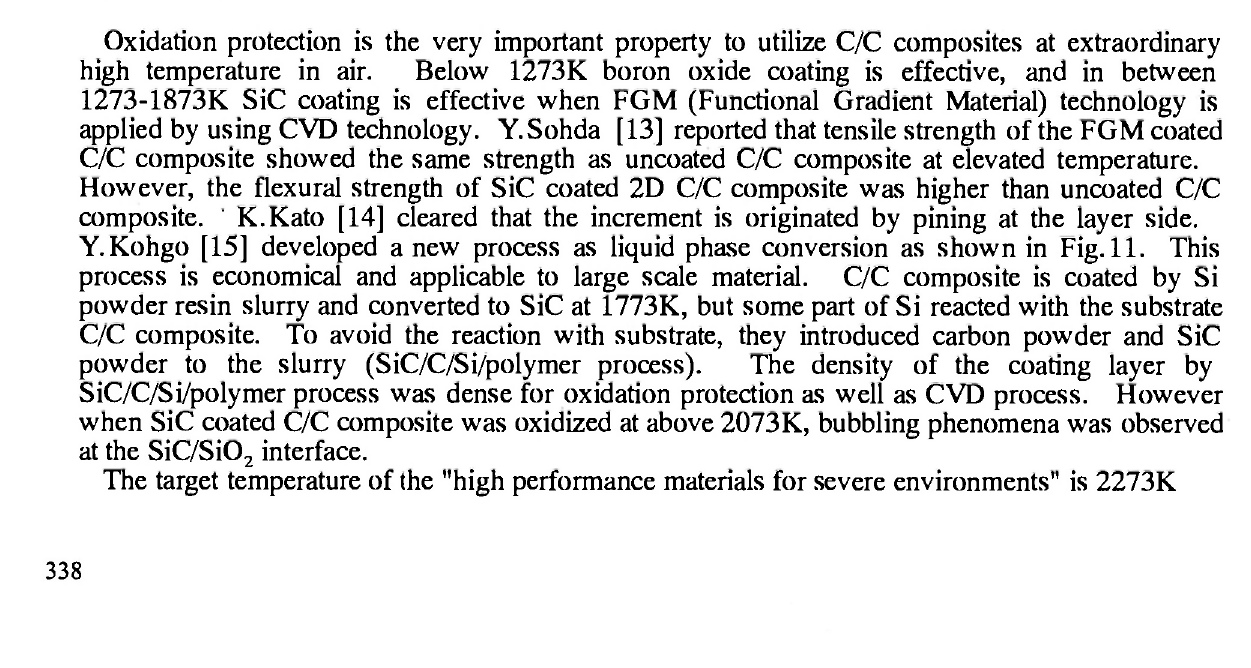
.10 Temperature dependence of thermal conductivity for pitch based UD C/C